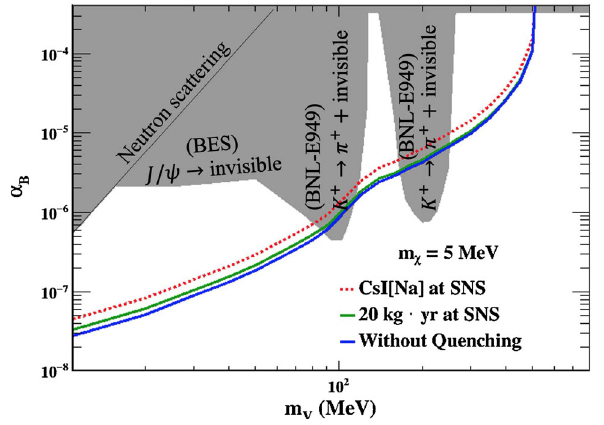
Fig. 18 Predicated90%sensitivitytolow-amssdarkmatterproduction parameters in case of the baryonic portal